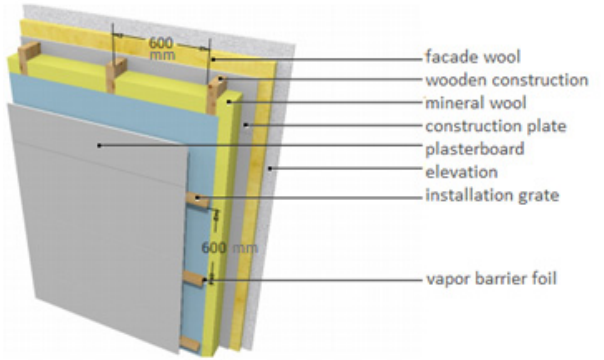
Figure 20. Wall cross section of an energy-saving house E2 (E2—a minimum basic standard that meets the requirements of the European Union).